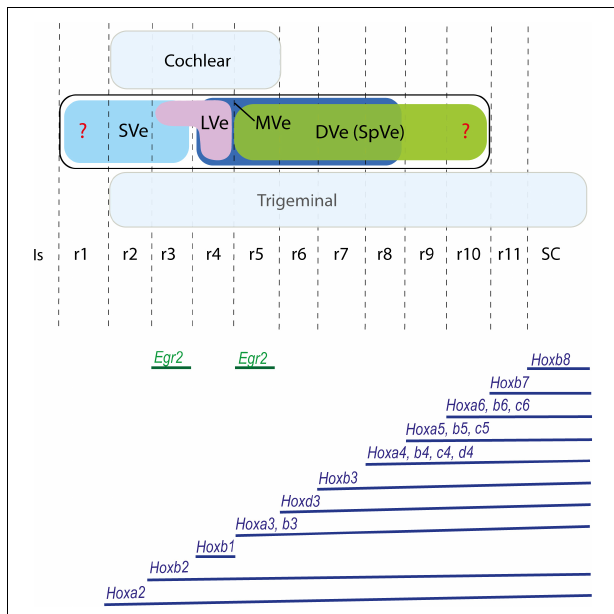
FIGURE 2 | Proposed rostrocaudal plurisegmental origins of the cytoarchitectonically defined vestibular nuclei (upper panel) and associated Hox expression pattern (lower panel) in the mouse. Egr2 gene, expressed selectively in rhombomeres 3 and 5, is also illustrated. Dorsal cochlear and ventral trigeminal columns are highlighted in light blue. Red question marks indicate uncertain rostral and caudal limits of the vestibular column. The Hox expression pattern shows species variability and differences throughout development. Schemes based on Pasqualetti et al. (2007); Chen et al. (2012); Di Bonito et al. (2015); Tomás-Roca et al. (2016); Krumlauf and Wilkinson (2021). DVe (SpVe), descending (inferior) vestibular nucleus; Is, isthmus; LVe, lateral vestibular nucleus; MVe, medial vestibular nucleus; r, rhombomere; SC, spinal cord; SVe, superior vestibular